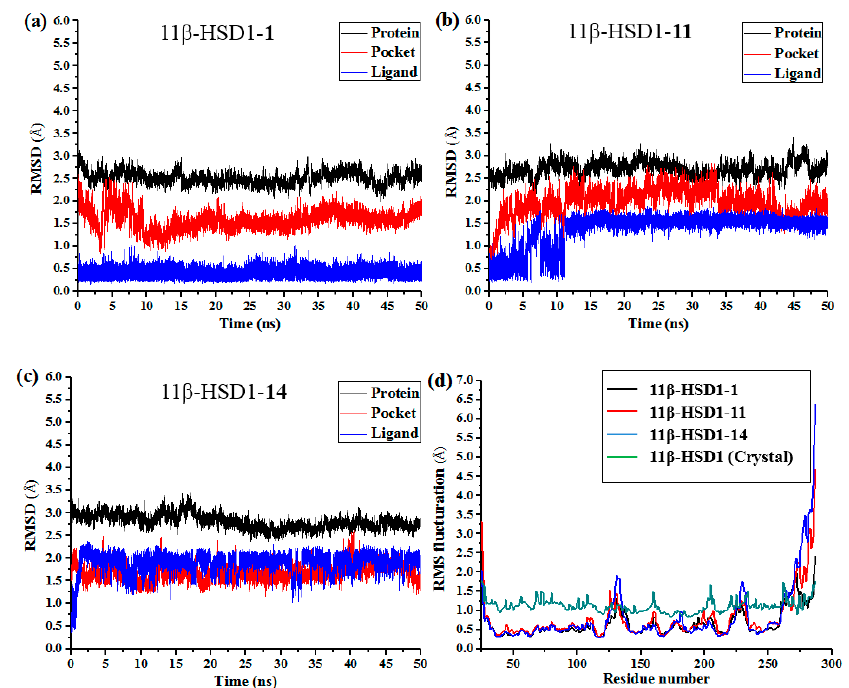
Figure 6. RMSDs of backbone atoms (C, C α , and N) of the protein, backbone atoms of residues in the binding pocket (within 5 Å around each inhibitor), and the heavy atoms in the ligand for ( a ) 11 β - HSD1- 1 , ( b ) 11 β -HSD1- 11 , ( c ) 11 β -HSD1- 14 , ( d ) RMSF of each residue of protein for all three ( a ) 11 β -HSD1- 1 ; ( b ) 11 β -HSD1- 11 ; ( c ) 11 β -HSD1- 14 ; ( d ) RMSF of each residue of protein for all three complexes obtained from 50 ns MD simulations and crystal structure. complexes obtained from 50 ns MD simulations and crystal